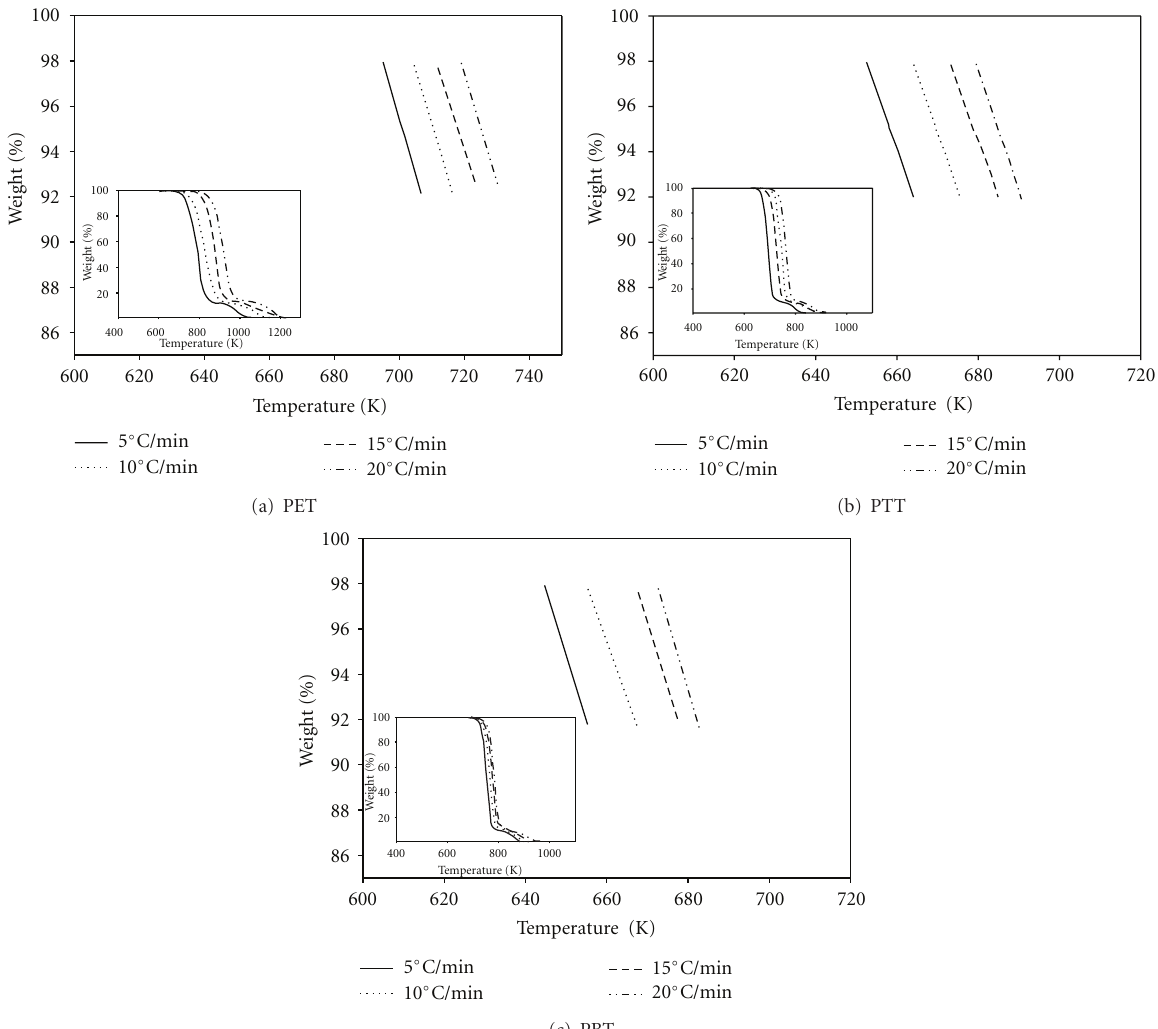
and the preexponential factor for degradation of these polyesters. The E and A for the two di ff erent g ( α ) functions were calculated at constant heating rates by fitting ln g ( α ) /T 2 versus 1 /T plots. It was observed that when g ( α ) for the Arrhenius parameter estimation in the CR equation, correlation coe ffi cient values greater than 0.99 was obtained (Figure 3). When g ( α ) 2 was used in the CR equation, the plots obtained had a correlation coe ffi cient less than 0.97. Figure 4 is a plot indicating the poor